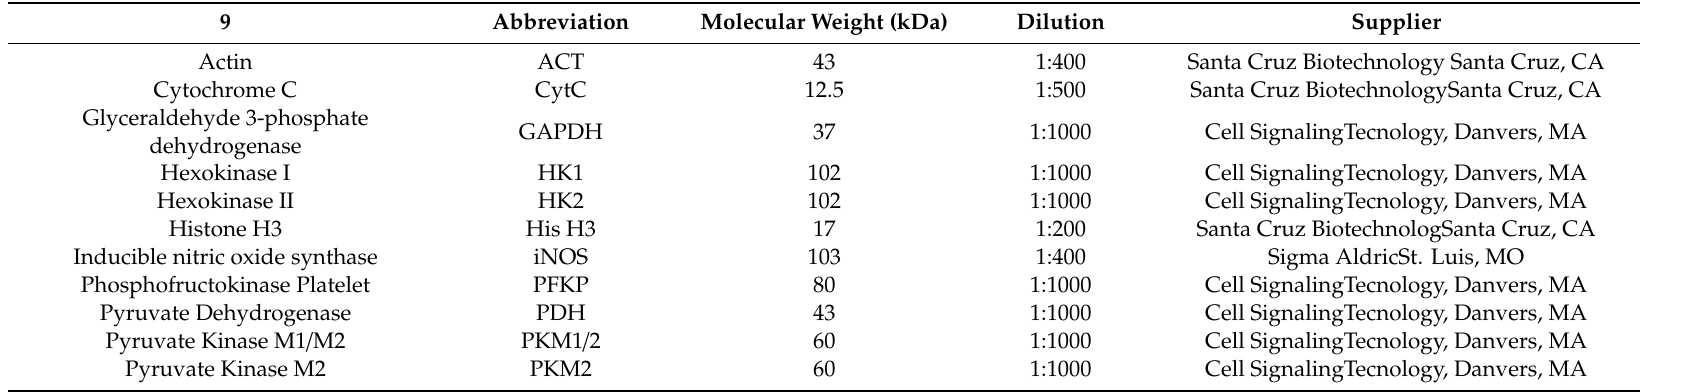
Table 2. List of